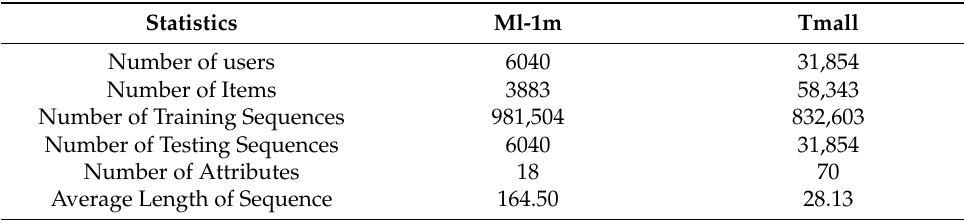
Table 1. Statistics of